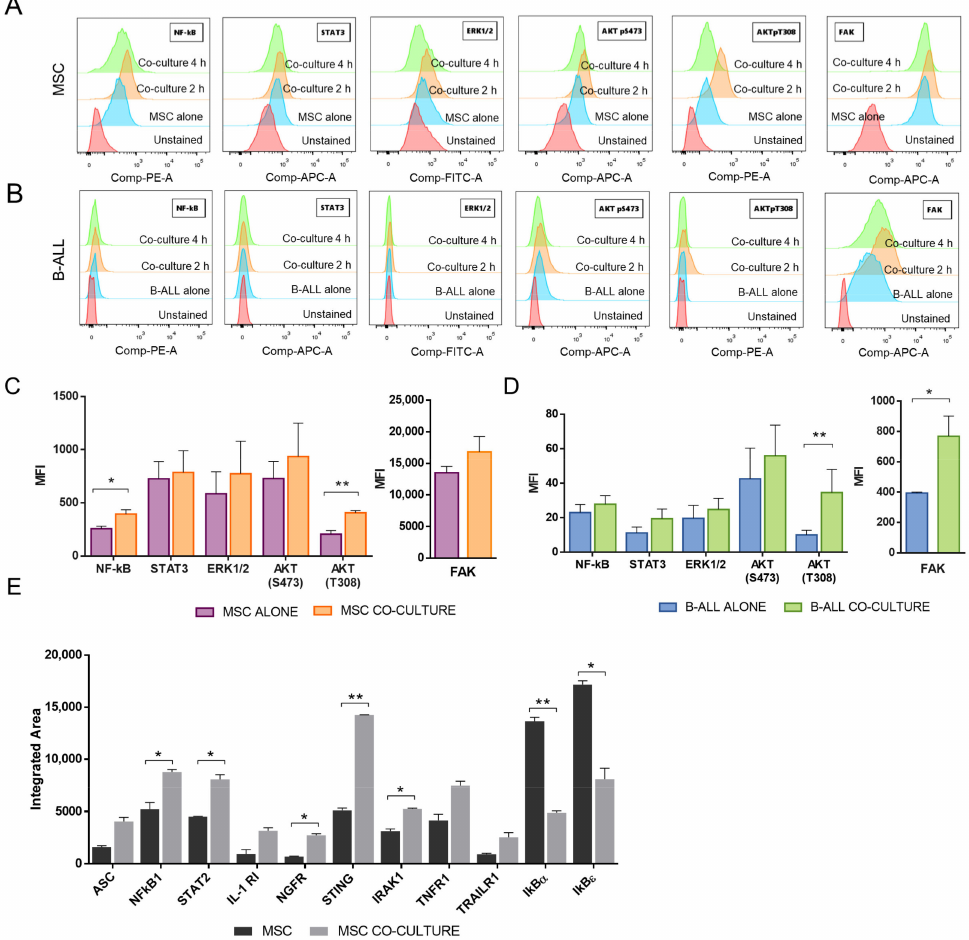
Figure 2. Direct contact between B-ALL cells and MSC involves mainly the activation of AKT and NF- κ B signaling in the stromal support. ( A , B ) Changes in the activation of AKT, FAK, STAT3, NF- κ B, and ERK in MSC ( A ) and B-ALL cell ( B ) populations. The phosphorylation status of the mentioned molecules was evaluated by flow cytometry. The co-cultures were established for 2 or 4 h, then non-adherent B-ALL cells were removed, and co-cultures were trypsinized, fixed, permeabilized, and incubated with phospho-specific antibodies. ( C , D ) Quantification of the activation of AKT, FAK, STAT3, NF- κ B, and ERK, measured as MFI in MSC ( C ) and B-ALL cells ( D ) after 2 h of co-culture. Data correspond to three independent experiments. ( E ) Changes in the expression of molecules involved in NF- κ B signaling. Protein extracts of MSC were obtained from MSC alone or in co- culture for 2 h with B-ALL cells; lysates were incubated in microarrays in order to evaluate 41 different molecules. Quantification of the dot density in the microarray is shown. In the graph, the molecules that increased or decreased by more than 50% are depicted. Data are from one experiment in duplicate and expressed as mean ± SEM ( p values: Non-parametric one-way ANOVA (C y D) * p < 0.05, ** p < 0.01; and multiple t -test ( E ) * p < 0.05, ** p <